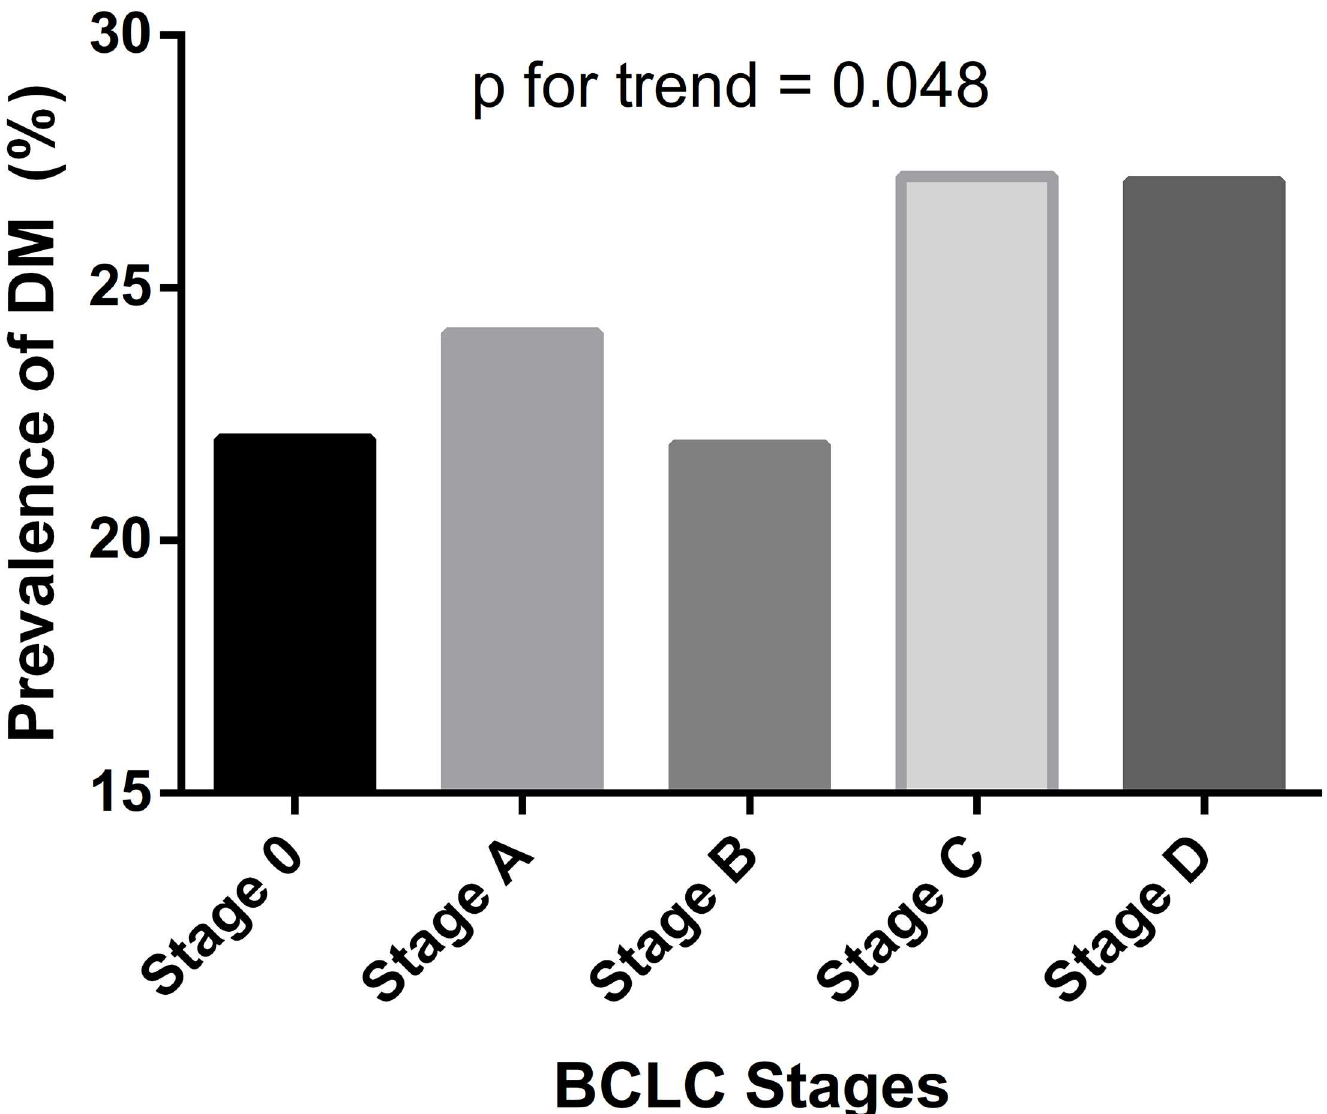
Fig 1. Prevalence of Diabetes Mellitus (DM) in different BCLC stages. A trend toward increasing DM prevalencein more advancedBCLC stages is seen at a marginalsignificance(p for trend = 0.048).